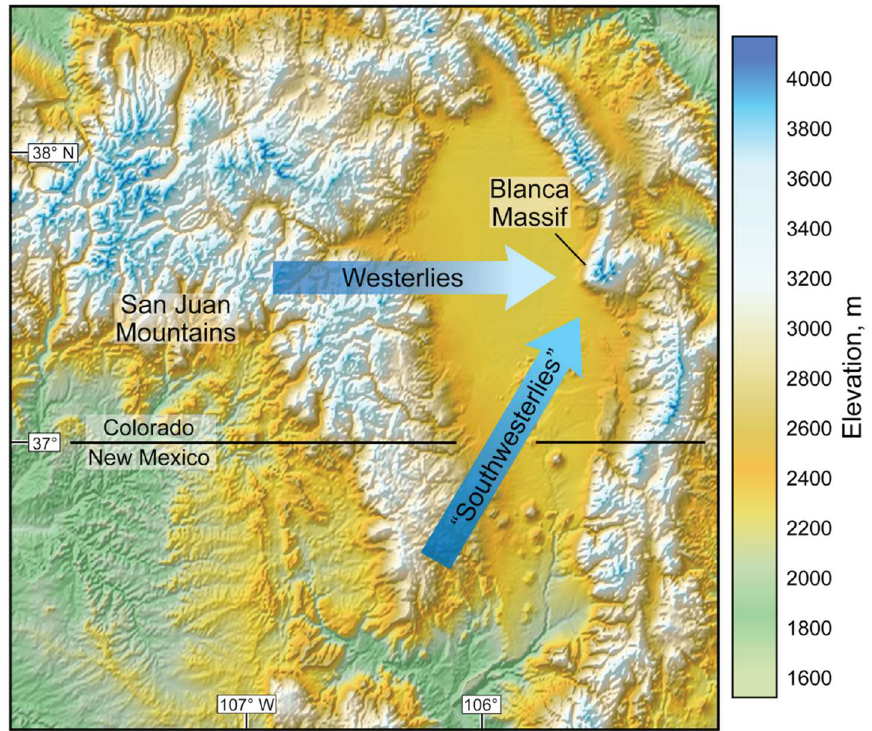
Figure 12. Regional topography and modern transport of Pacific-derived moisture to the Sangre de Cristo Mountains and the Blanca Massif. Note air masses arriving from the west pass over a broad area of high topography of the San Juan Mountains that results in less moisture delivery to the Sangre de Cristo Mountains than that from air masses arriving from the southwest.